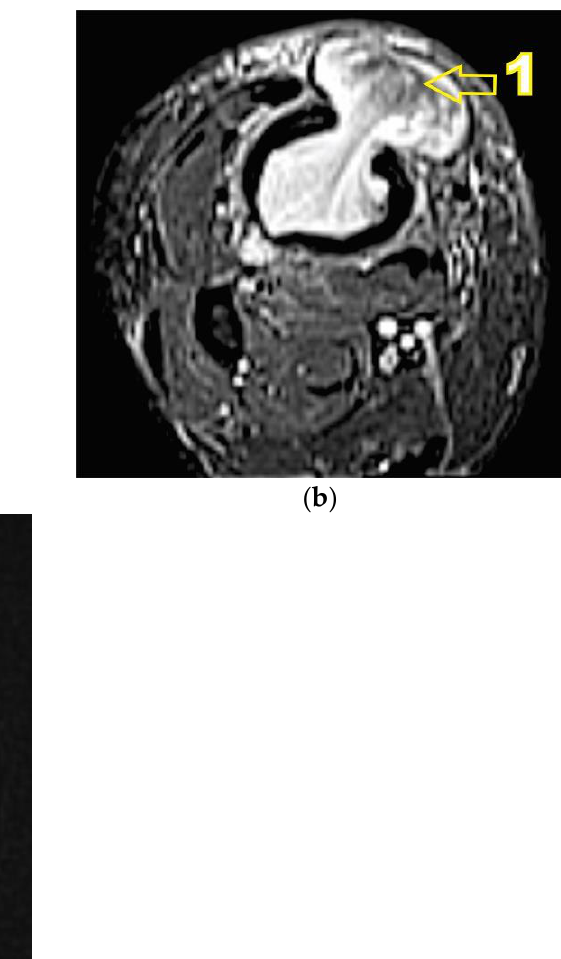
Figure 5. ( a ) CT axial section. 1—extraosseous expansion of the tumor formation; ( b ) CT coronal